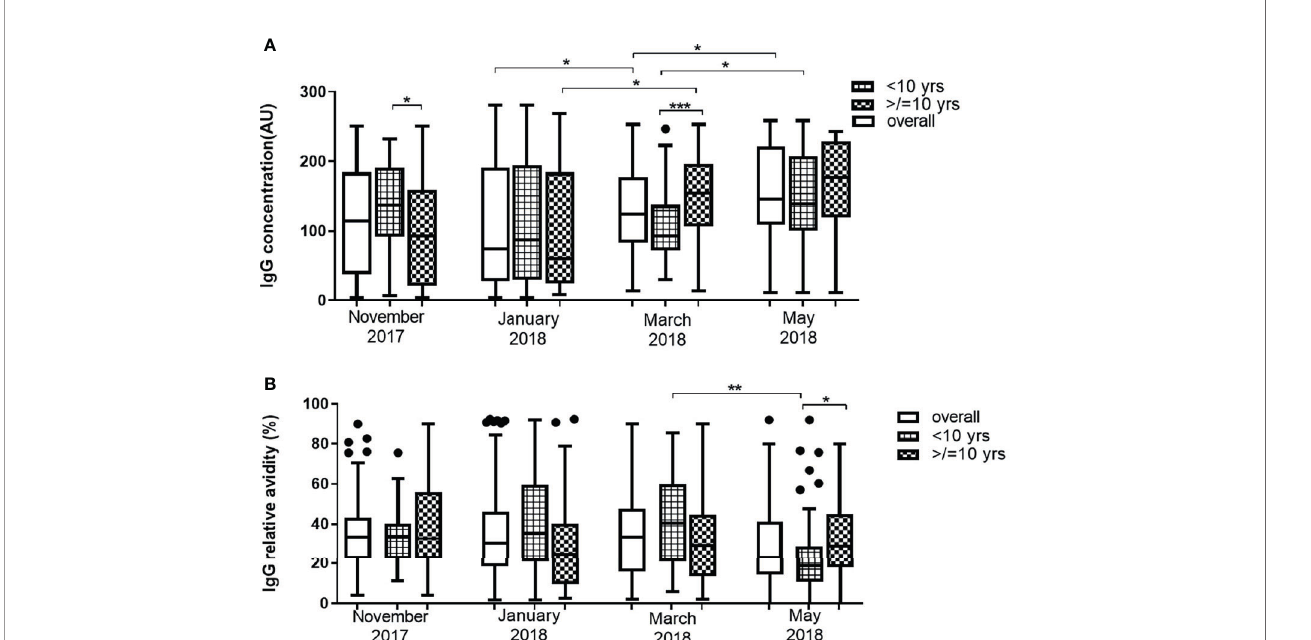
FIGURE 3 | Changes in Pfs230 IgG level (A) and avidity (B) in 43 children <10 years and 41 children ≥ 10 years over the dry season spanning November 2017 to May 2018. The extent of statistically signi fi cant difference in measurements indicated by *, ** and *** represent P <0.05, P <0.01, and P <0.001